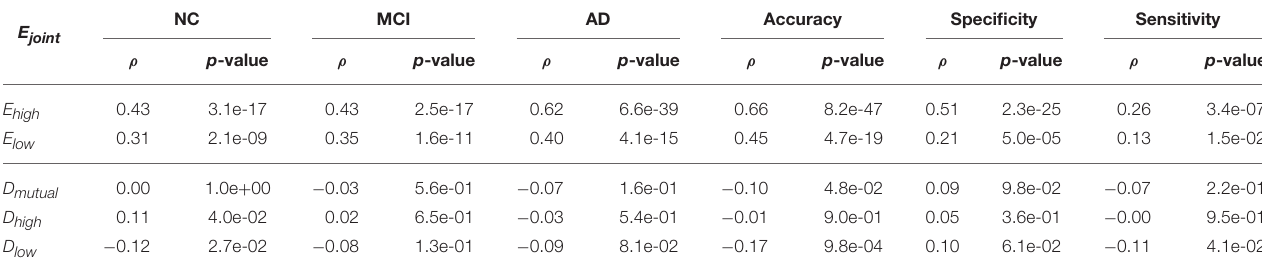
TABLE 4 | Pearson’s correlation coefficient of the performance and the